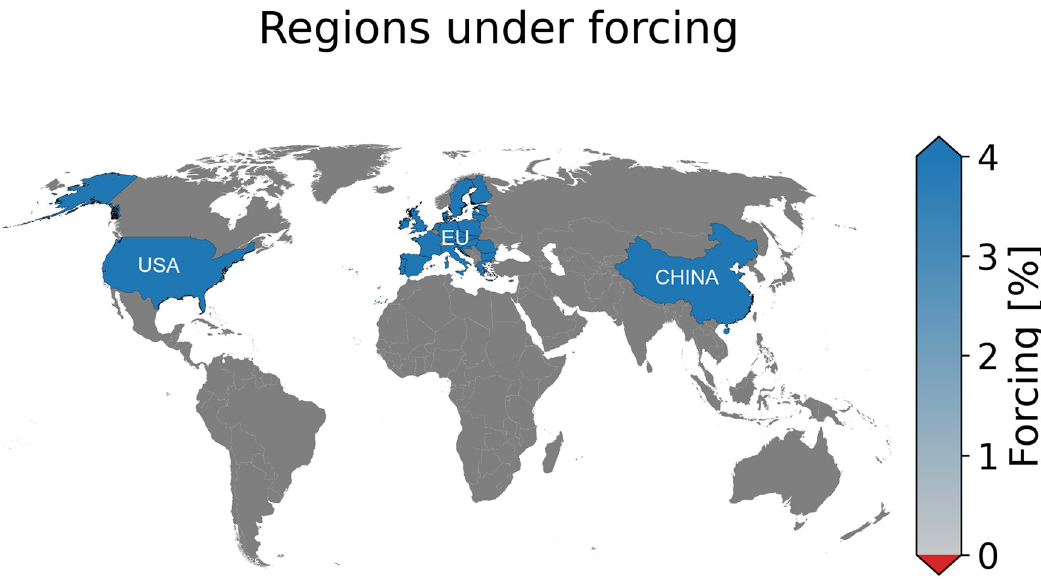
Fig 1. The major breadbasket regions under study and regions affected by the defined events. This figure was generated with the Mapping package in python.